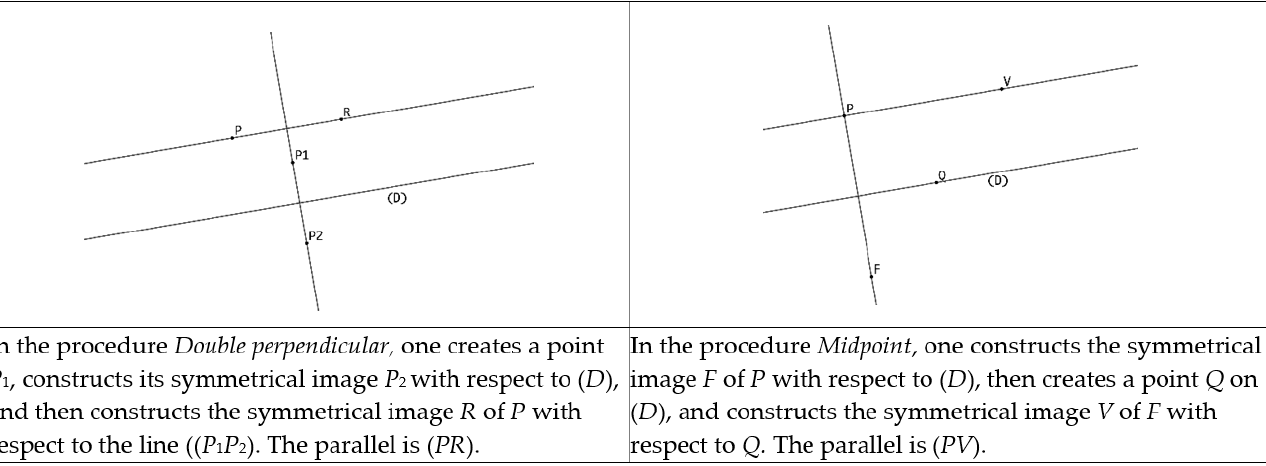
to exploit DGE. A long learning process is necessary, as shown for instance by the 3 year project described in